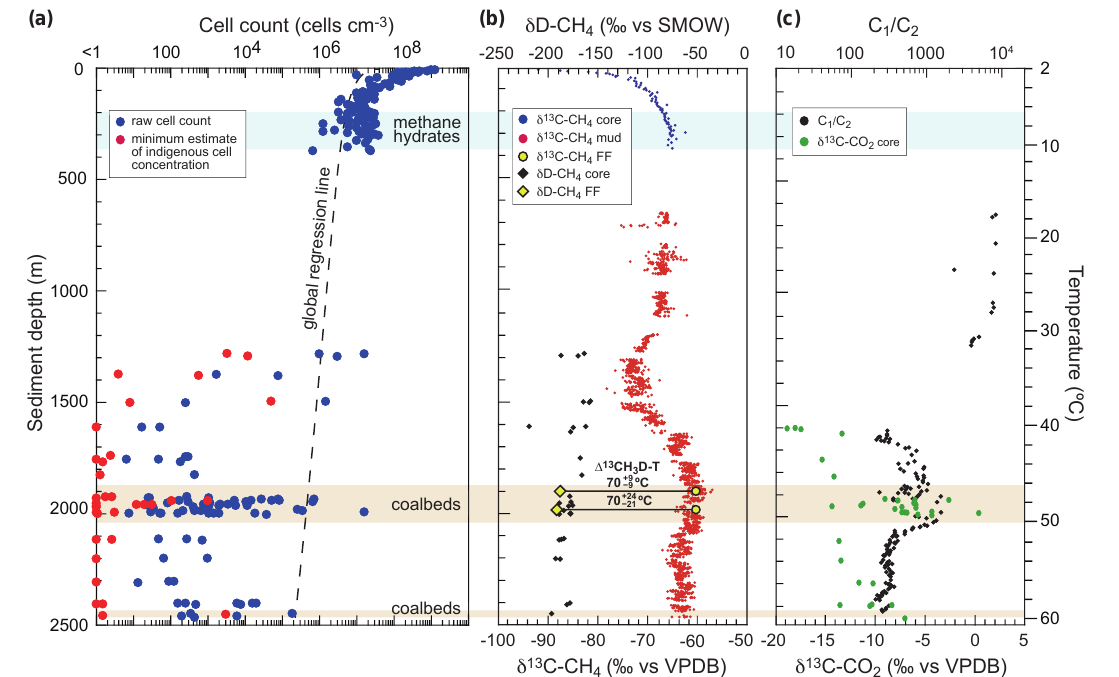
Figure 4. Depth profiles of (a) microbial cell concentrations, (b) δ 13 C and δ D of methane, and (c) C 1 / C 2 ratios and δ 13 C of CO 2 at Site C0020 (Inagaki et al., 2015). Raw data of fluorescence image-based cell counts and the minimum estimates of indigenous cell concentrations corrected for contamination based on molecular data are shown by blue and red symbols in (a) , respectively. The minimal quantification limit for raw cell counts was 1.43 × 10 2 cellscm − 3 ; i.e., the upper 95% confidence interval of negative background. All δ 13 C and δ D in (b) and (c) are in ‰ versus Vienna Pee Dee belemnite (VPDB) and Standard Mean Ocean Water (SMOW), respectively. The (cid:49) 13 CH 3 D–T values designate the apparent equilibrium temperatures derived from measurements of a clumped isotopologue of methane ( 13 CH 3 D) in discrete formation fluid (FF) samples obtained using the QuickSilver MDT-Probe in situ. Temperature in (c) is based on the temperature gradient of 24.0 ◦ Ckm − 1 determined by downhole logging. Cell concentration and δ 13 C of methane in the upper sedimentary sequence (0–365mb.s.f.) were obtained at the same location during the JAMSTEC Chikyu shakedown expedition CK06-06 in 2006. This figure is slightly modified from Fig. 1 in Inagaki et al. (2015), and reprinted with permission from